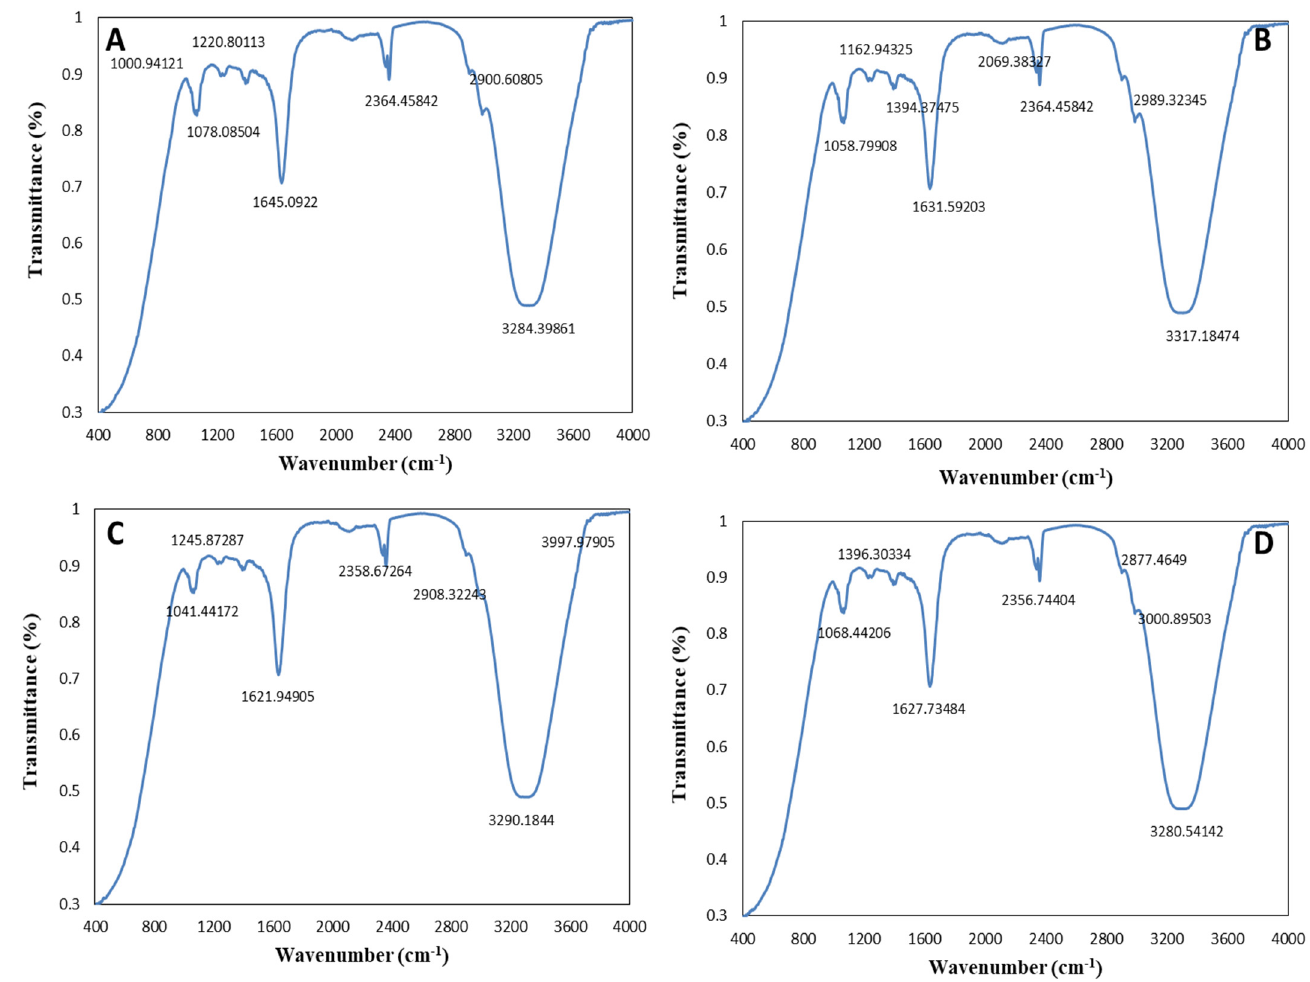
Figure 6. FTIR spectra of bimetallic Ag–ZnONPs. ( A ) Control Ag–ZnO (0.1/0.1). ( B ) UV-C mediated Ag–ZnO (0.1/0.1). ( C ) Control Ag–ZnO (0.1/0.5). ( D ) UV-C mediated Ag–ZnO (0.1/0.5).